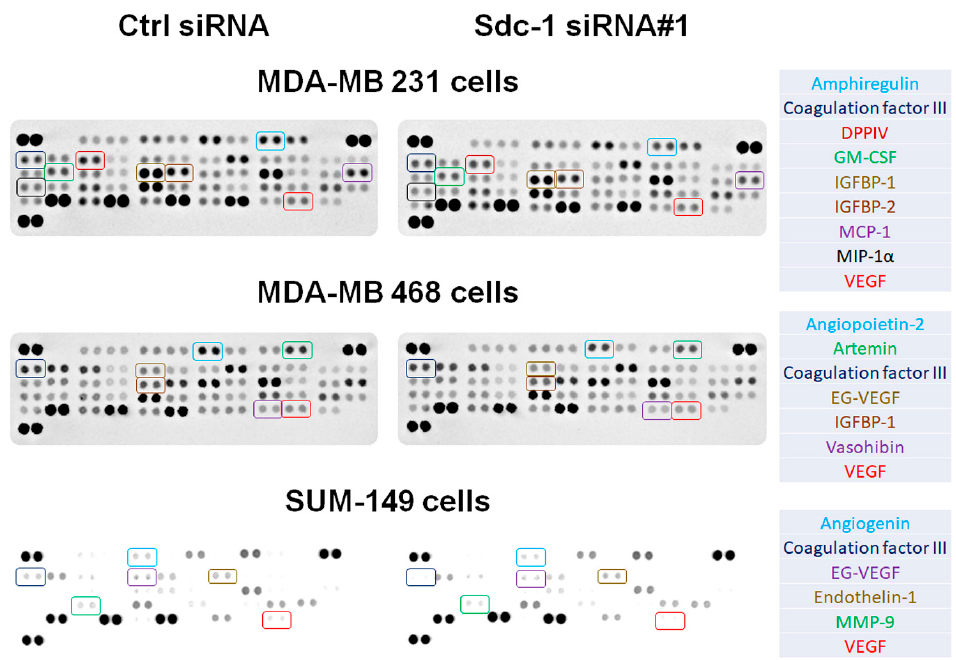
Figure 2. Sdc-1 expression affects the expression and secretion of angiogenesis-related factors. Profiling of angiogenesis- regulating molecules secreted by control and Sdc-1 siRNA transfected cells in a 3D co-culture model with HUVECs as analyzed by proteome profiler™ human angiogenesis antibody array. Media conditioned by the secretome of control or the indicated Sdc-1 siRNA-treated TNBC cells co-cultured in 3D with HUVECs were collected and subjected to pro- filing. Colored boxes indicate common and cell type-specific dysregulated factors. See Supplementary Figure S2 for densitometric